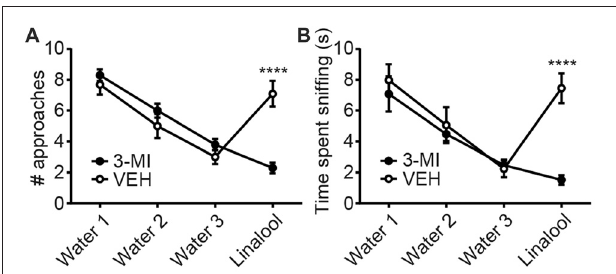
FIGURE 4 | Confirmation of olfactory deprivation caused by 3-MI administration in olfactory habituation/dishabituation test. Number of approaches (A) and time spent sniffing (B) to the water-soaked cotton swab were not different between vehicle and 3-MI treated mice, but both to the linalool-soaked cotton swab were significantly decreased in 3-MI treated anosmic mice. VEH, mice administered vehicle (corn oil, i.p.); 3-MI, mice administered 3-MI (300 mg/kg, i.p.); Water, distilled water (200 µ L); Linalool, Linalool (200 µ L). n = 10 for all groups. Results are expressed as mean ± SEM. ∗∗∗∗ P < 0.0001 ( post hoc Bonferronie’s multiple comparison test).